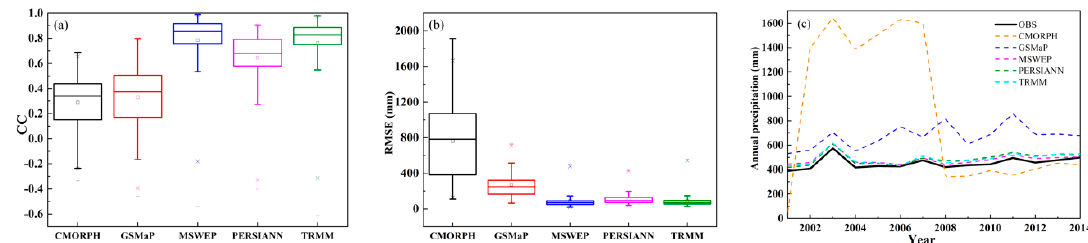
Figure 2. ( a ) correlation coefficient, ( b ) root mean square error of annual precipitation between gridded and gauge datasets, and ( c ) temporal variation of annual precipitation. CC is correlation coefficient, RMSE is root mean square error. (The center line of each boxplot depicts the median value (50th percentile) and the box encompasses the 25th and 75th percentiles of the sample data. The small squares in each boxplot is the arithmetic mean. The whiskers extend from Q1 – 1.5 × (Q3 – Q1) to Q3 + 1.5 × (Q3 – Q1), where Q1 and Q3 are the 25th and 75th percentiles of the sample data, respectively, similarly hereinafter).